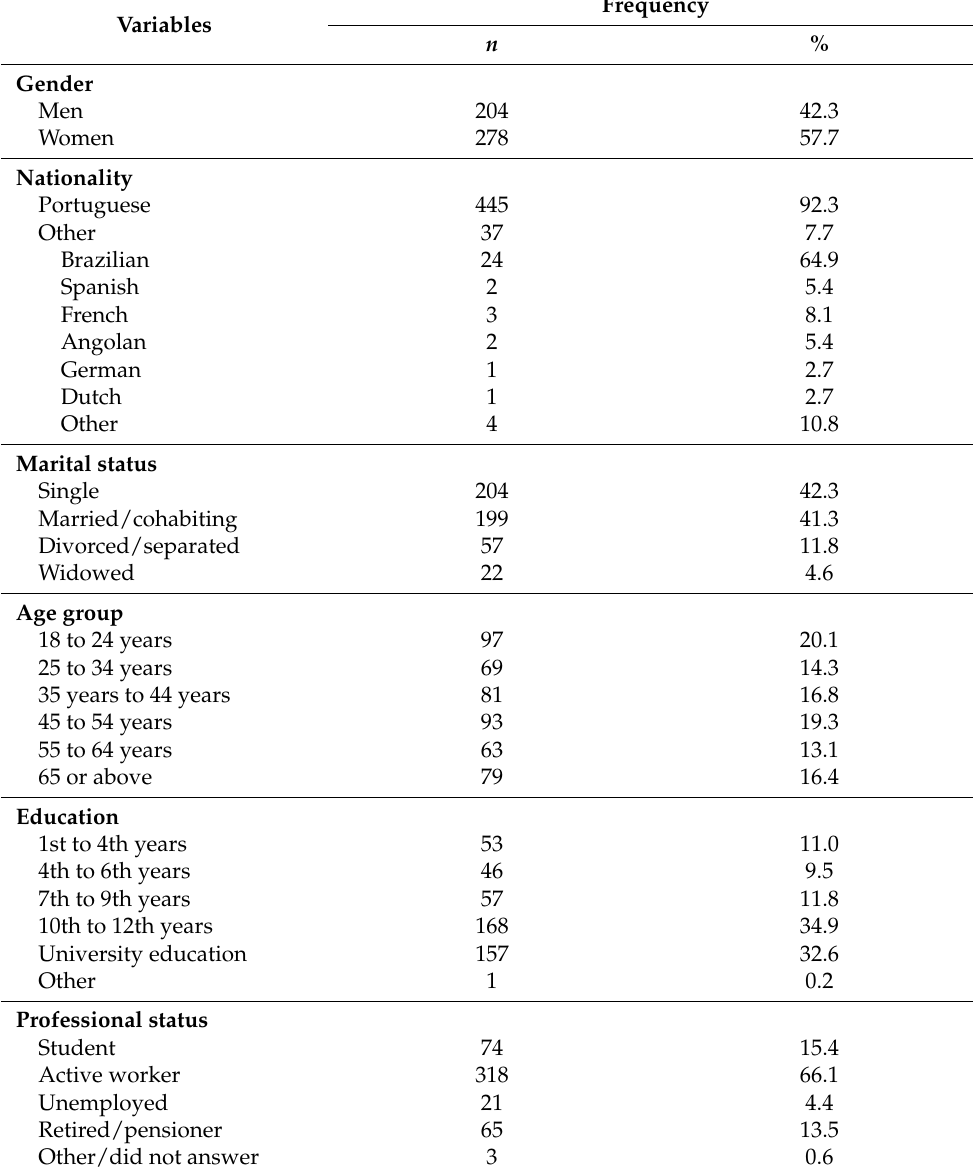
Table 1. Participant description ( N =